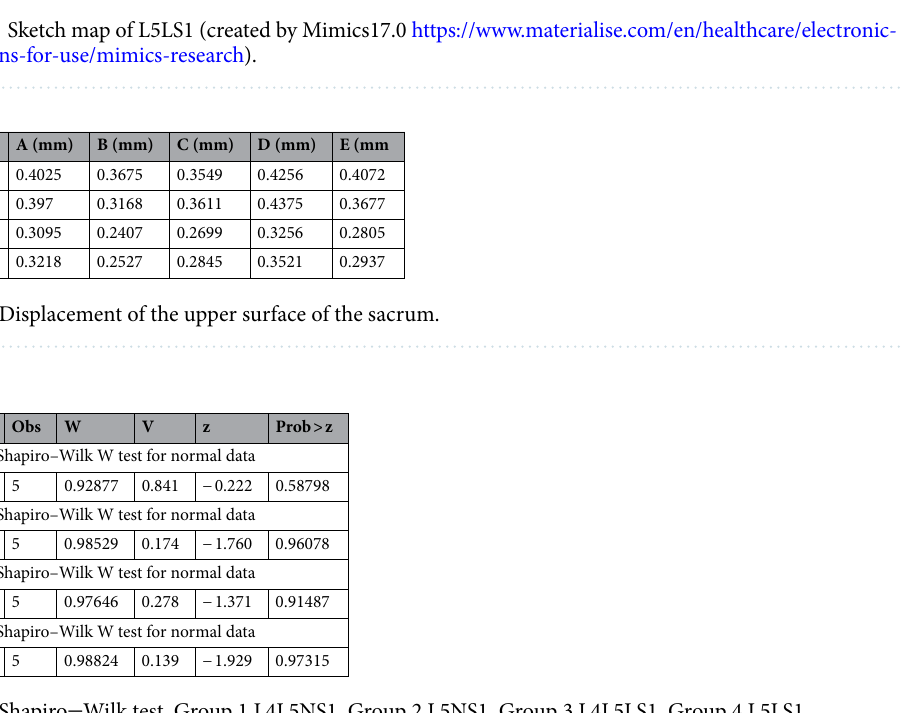
Table 4. Shapiro ‒ Wilk test. Group 1 L4L5NS1, Group 2 L5NS1, Group 3 L4L5LS1, Group 4 L5LS1.